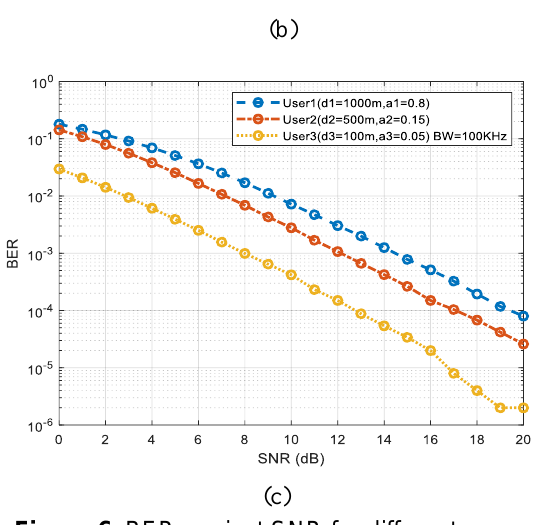
Figure 6. BER against SNR for different bandwidths, and distances for three users